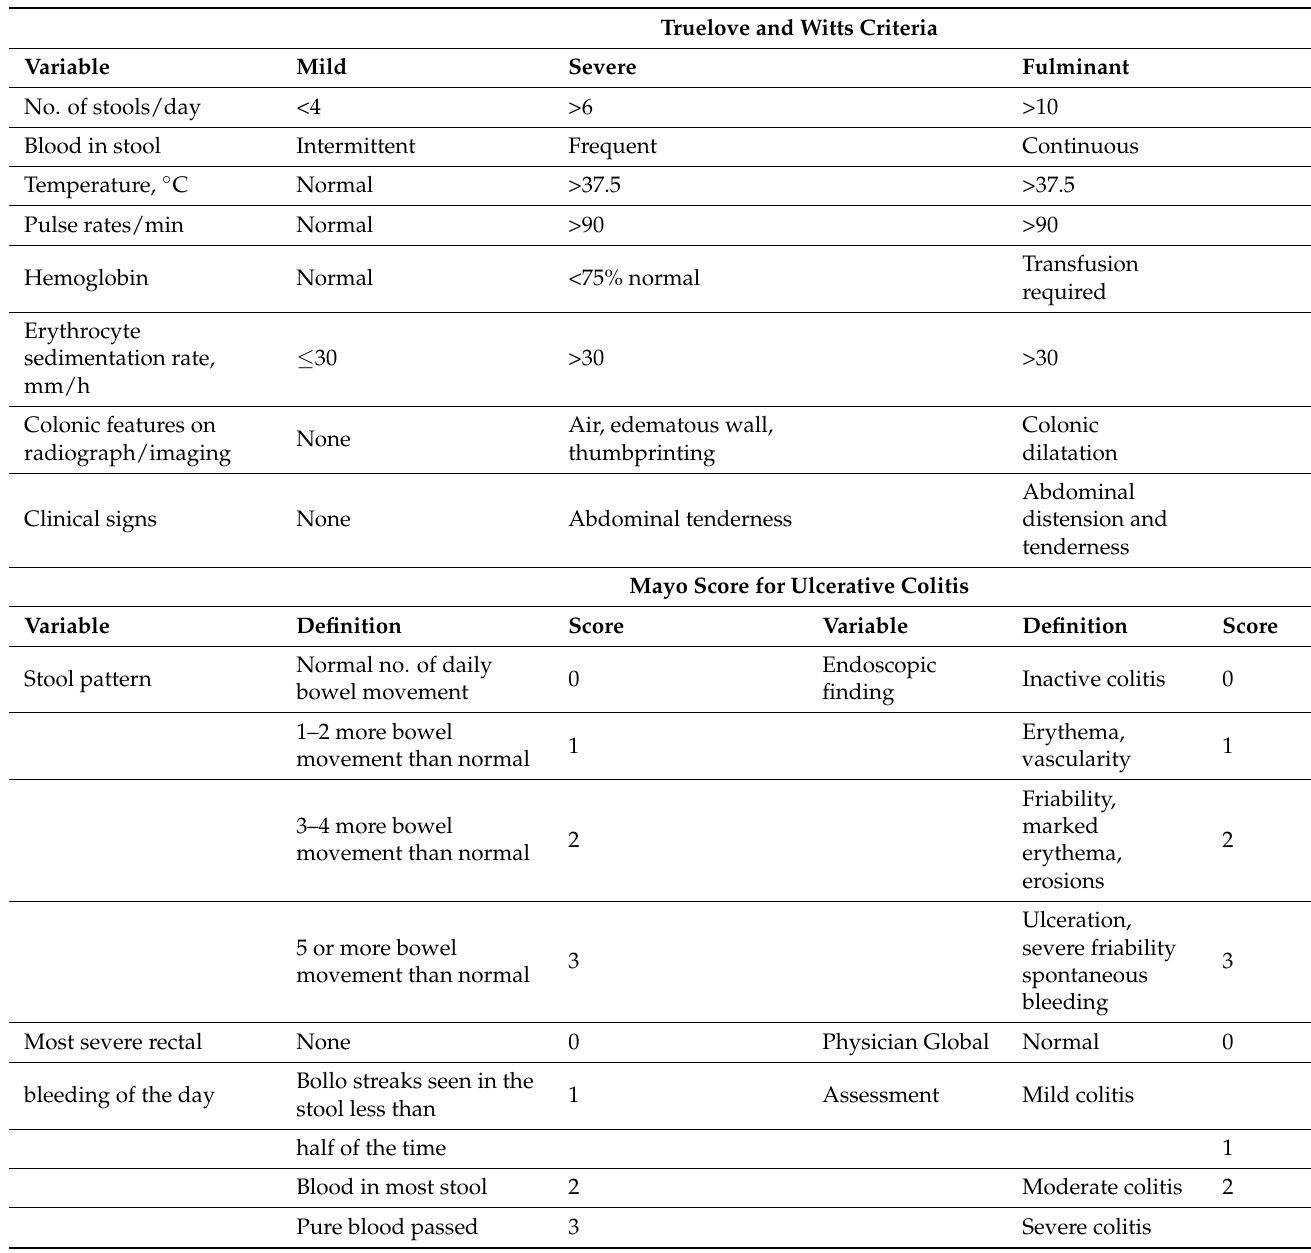
Table 1. Disease severity scoring systems. Reprint/adapted with permission from Refs.